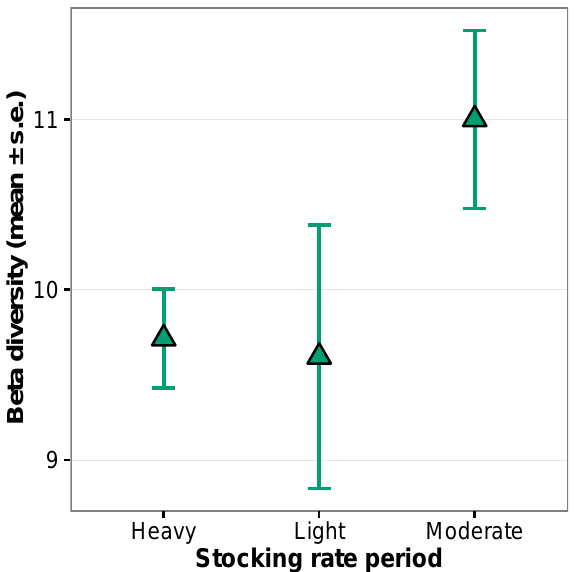
Figure 3. Mean beta diversity of plant functional groups, measured here as multivariate dispersion , or distance to group centroid in ordination space, across stocking rates. Beta diversity underlies temporal stability of a resource (i.e., standing crop or vegetation